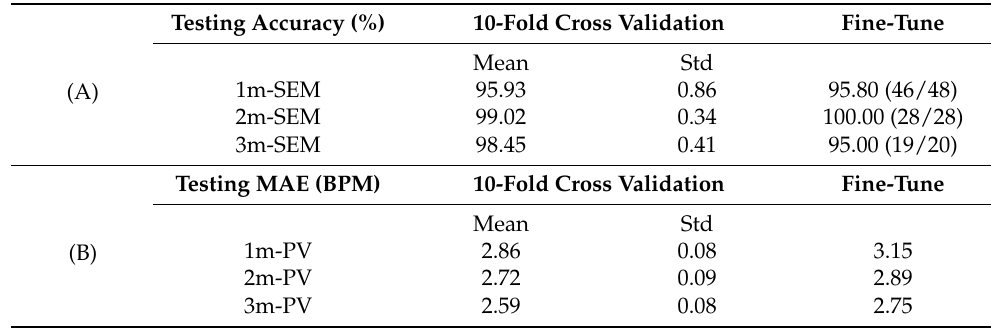
Table 2. ( A ). 10-fold cross validation accuracy and fine-tune accuracy of 1m-SEM, 2m-SEM and 1m-PV, 2m-PV and 3m-PV. Std: standard